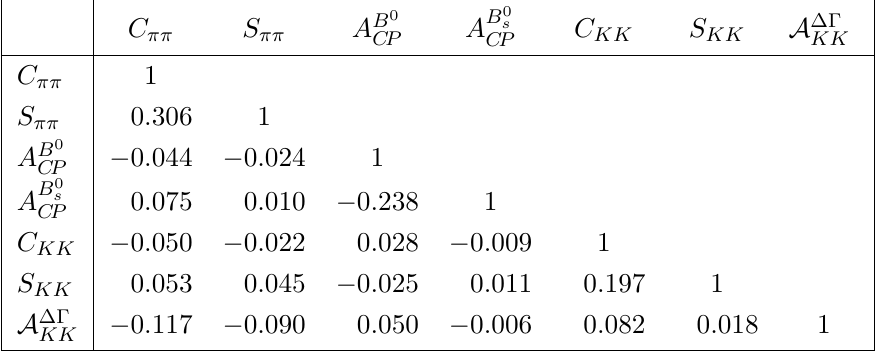
Table 4 . Correlations of systematic uncertainties among the CP -violating parameters. C KK